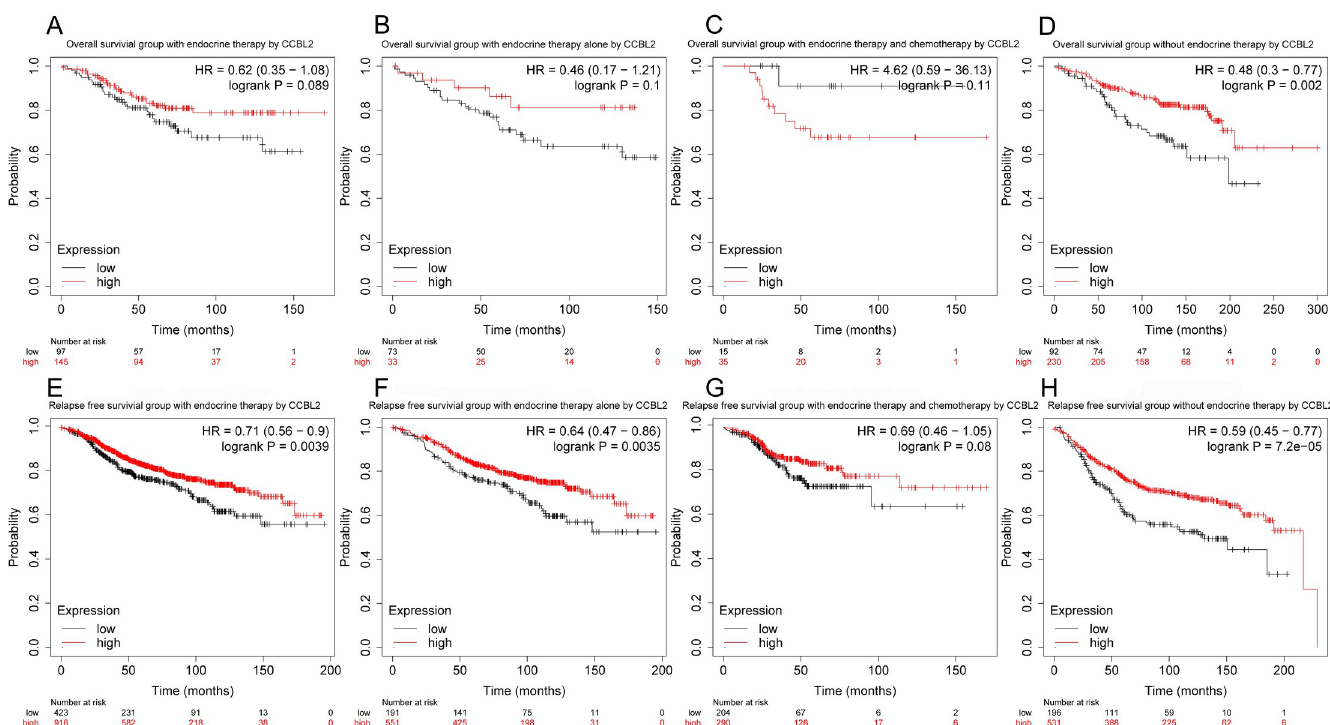
Fig 7. Kaplan–Meier curves of overall survival and relapse free survival in ER-positive breast cancer according to CCBL2 expression in breast cancer tissues. Subgroups analysis included the overall survival and relapse free survival of patients with endocrine therapy (A and E), with endocrine therapy alone (B and F), with endocrine therapy and chemotherapy (C and G), and without endocrine therapy (D and H). P value < 0.05 was the significance threshold.